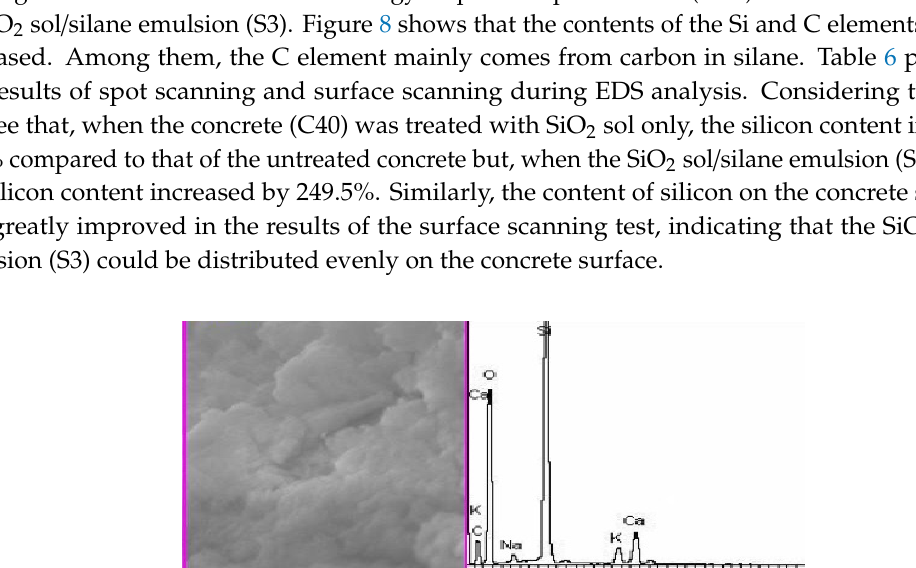
Figure 8. EDS results of the concrete surface treated by SiO 2 sol/silane emulsion (S3).